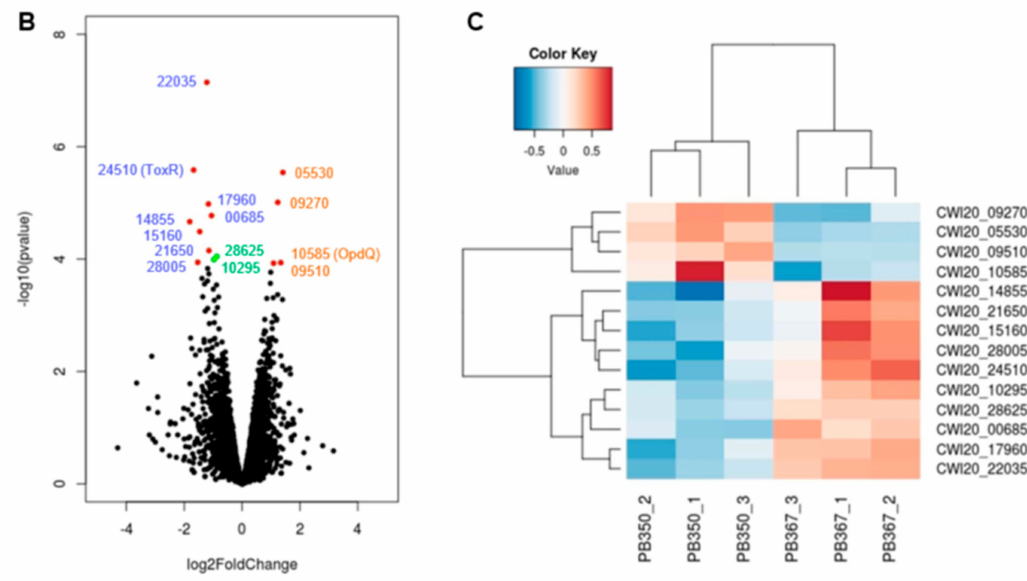
Figure2. Comparativeepigenomeandtranscriptomeanalysisof P.aeruginosa isolates. ( A )Genome-wide di ff erential methylation and gene expression in the paired P. aeruginosa isolates, PB367 and PB350. Top: Di ff erentially methylated adenosine (m6A, in red) and cytosine (m4C, in blue) in PB367 and PB350, within or without sequence motif (refer to Table 2), and their distribution throughout the whole genome. Bottom: 14 genes identified with significantly di ff erential expression (adjusted p -value < 0.05) and their particular loci at the genome. Upregulated genes in PB350 are labeled in brown, downregulated in blue, fold change less than 2 are in green; ( B ) Volcano plot of RNAseq for identification of 14 genes with significantly di ff erential expression; ( C ) Heatmap of genes with significantly di ff erential expression in triplicated samples. The color key represents the amount by which each gene deviates in a particular sample from the gene’s average across all the